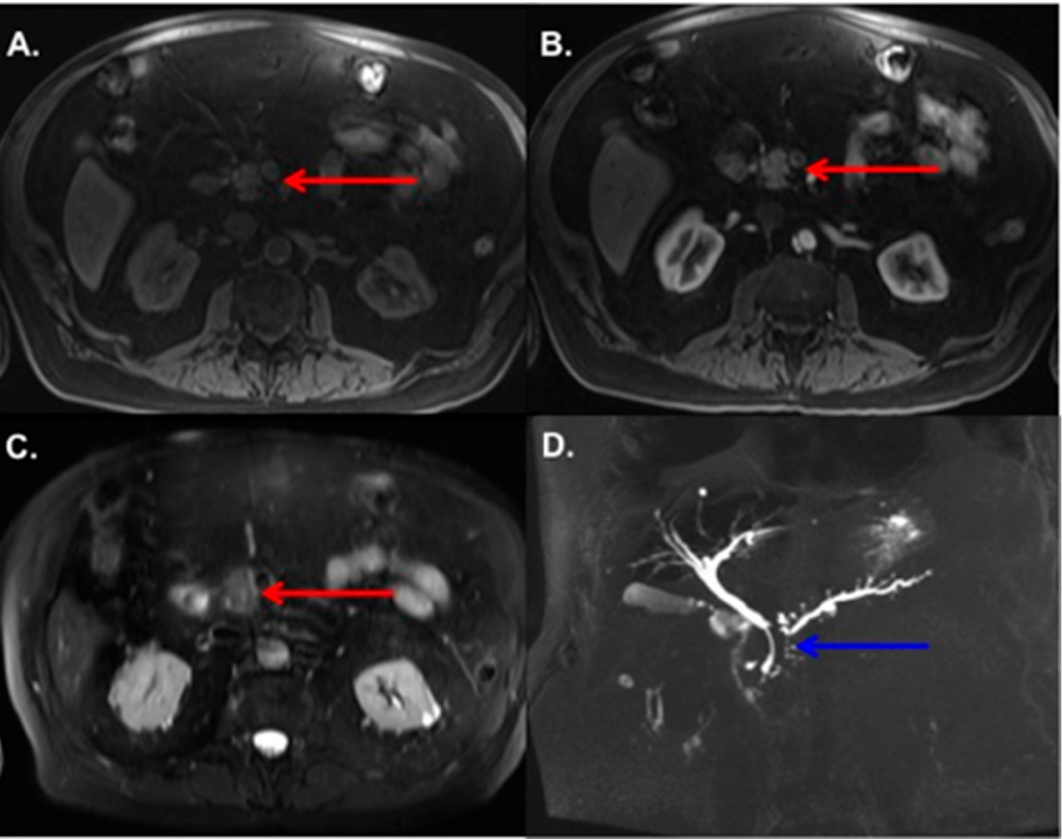
Figure 3. A 82-year-old male with a non-necrotic PDAC in the pancreatic head. ( A ) Axial T1 fat-suppressed image demonstrates hypointensity (red arrow). ( B ) Arterial phase image shows hypo-enhancement (red arrow). ( C ) T2 fat-suppressed image shows isointense signal (red arrow). ( D ) MRCP demonstrates narrowing of the lower common bile duct and pancreatic duct with upstream dilatation (blue arrow). No metastatic disease or lymphadenopathy was identified. The tumor was resected and no necrosis found.